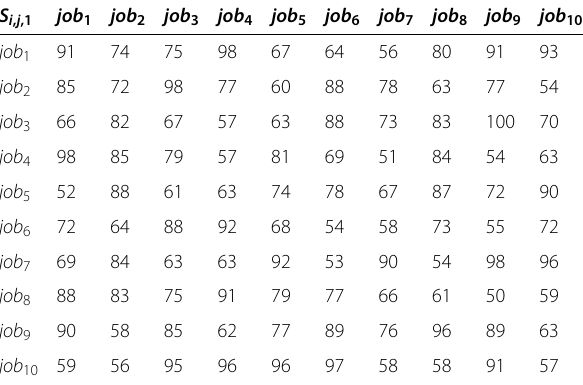
Table 3 Example of sequence-dependent setup times on machine 1